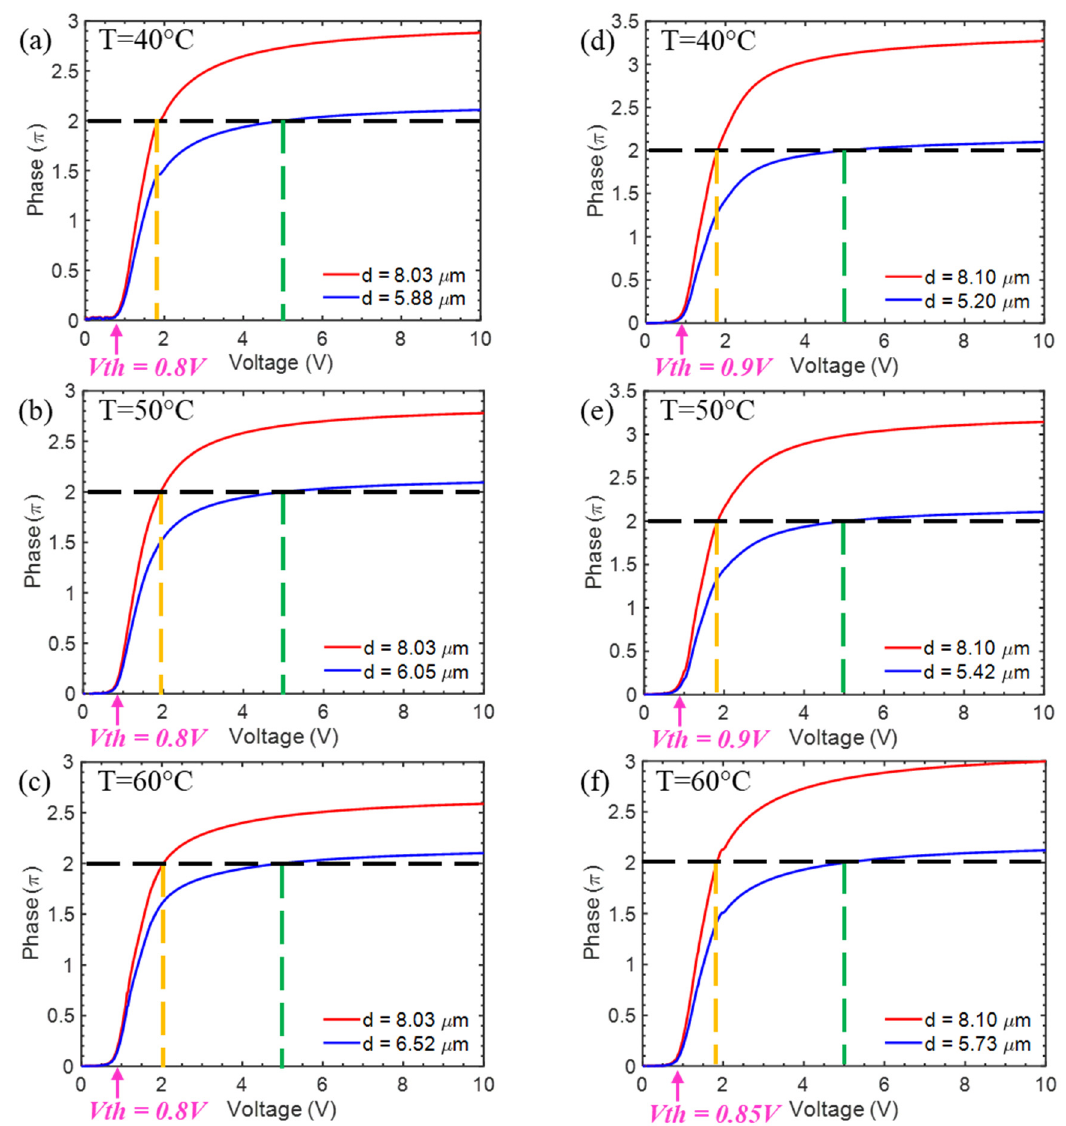
Figure 7. Measured (red lines) voltage-dependent phase change in a transmissive LCM-1107 cell ( a – c ) and LCM-2018 cell ( d – f ) at λ = 1550 nm, and the extrapolated (blue lines) voltage-dependent phase change of the corresponding optimal cell gaps at V 2 π = 5 V rms .